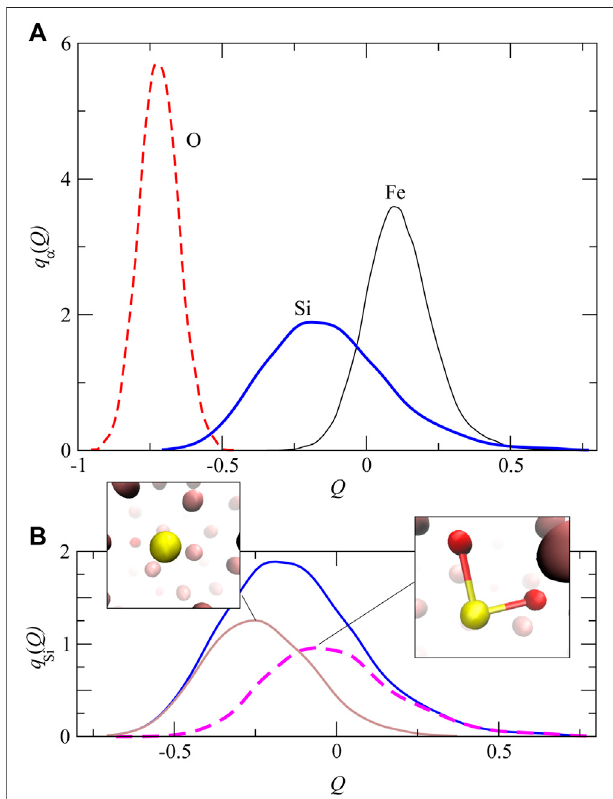
FIGURE 7 | (A) The distribution of q α ( Q ) of the gross charges Q i ∈ α . The thin solid, thick solid and dashed lines represent q Fe ( Q ), q Si ( Q ) and q O ( Q ), respectively. (B) The distribution of q Si ( Q ) decomposed into q Si – O ( Q ) and q Si – nonO ( Q ). The former represents the charge distribution for Si atoms coordinated to O atoms (a pink thin – dashed line) and the latter represents the chargedistribution ofSiatoms unbonded toOatoms(a brownthin – solidline).